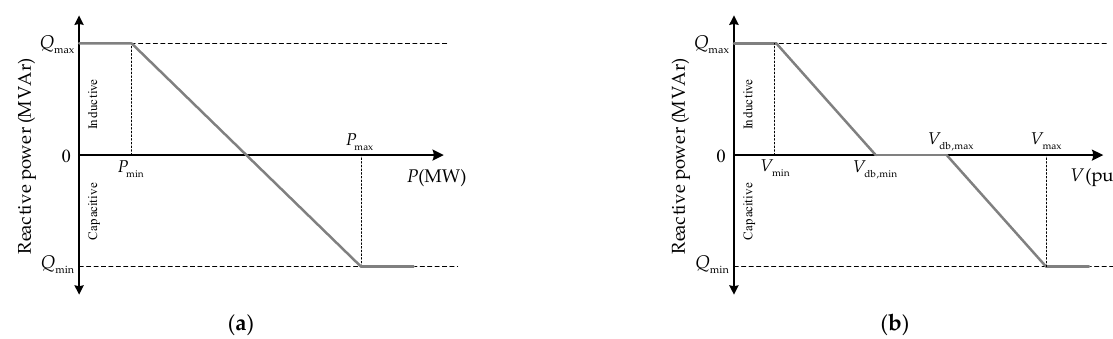
Figure 5. Curve characteristic based reactive power control at smart converter: ( a ) Watt–Var–characteristic; ( b ) Volt–Var–characteristic.